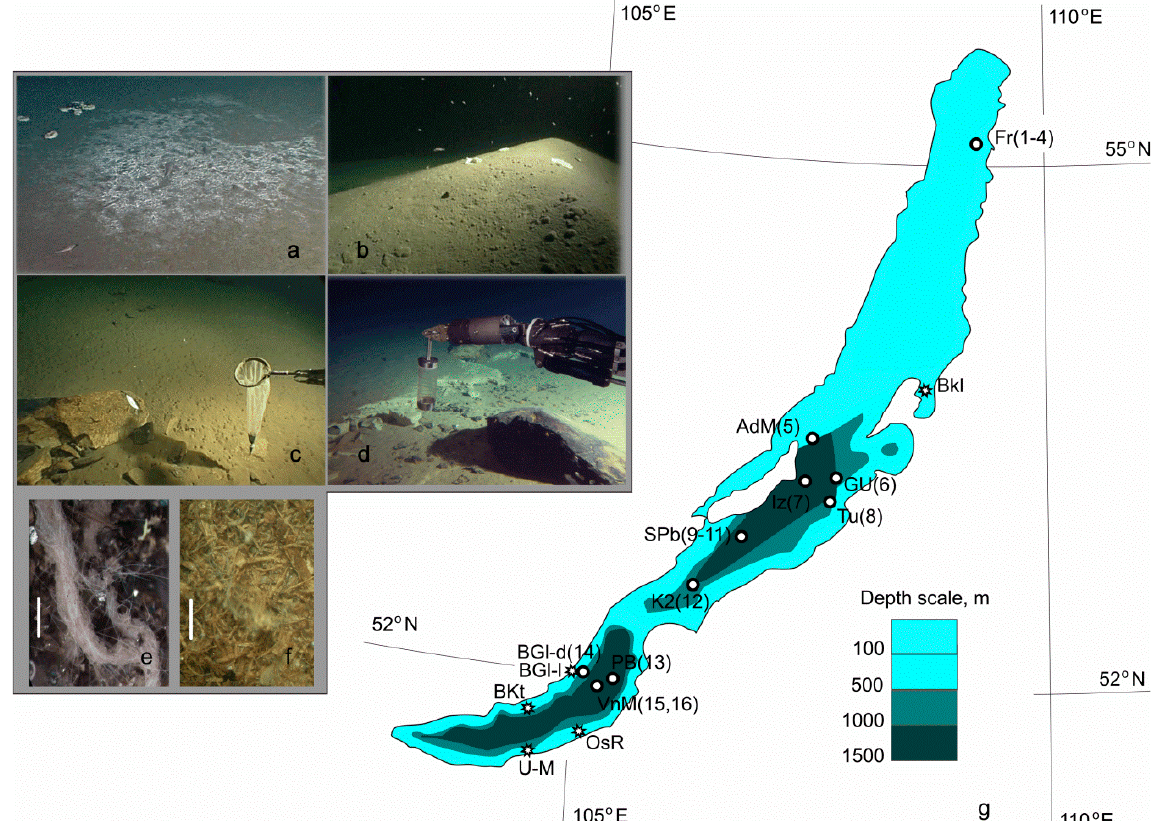
Figure 1. Photographs of Lake Baikal bottom ( a – d ) taken by underwater submersibles Mir , washed sediments ( e , f ), and map of the locations of sampling stations ( g ). ( a )—Frolikha hydrothermal seep, bacterial mat, and sponges; ( b )—hills of the Saint Petersburg methane seep with white flatworms on the apex and microbial mats; ( c )—bottom near Izhimei Cape, benthic net—equipment of the Mir ; ( d )—Academic Ridge, gravel, boulders and exposed mudstone, benthic core—equipment of the Mir ; ( e )—threads of the sulfur bacteria; and ( f )—silt and land ‐ plant detritus. Scale ( e , f ): l cm. Circles—studied sites of deep ‐ water zone; asterisk—studied sites of depths 10–100 m (abbrevia ‐ tion, see Tables 1 and 2), in brackets samples Nos. Table 1. Information regarding investigated samples from the deep ‐ water zone of Lake Baikal.